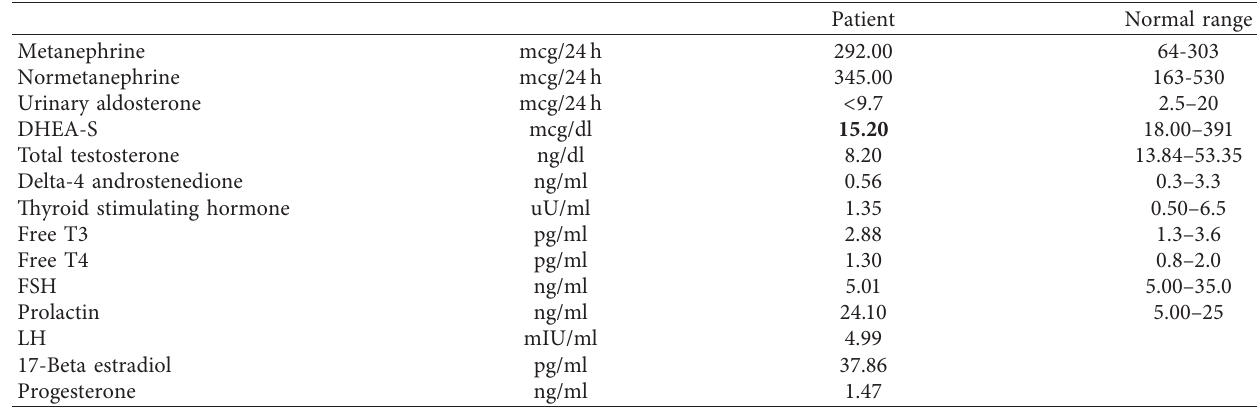
Table 2: Other hormonal